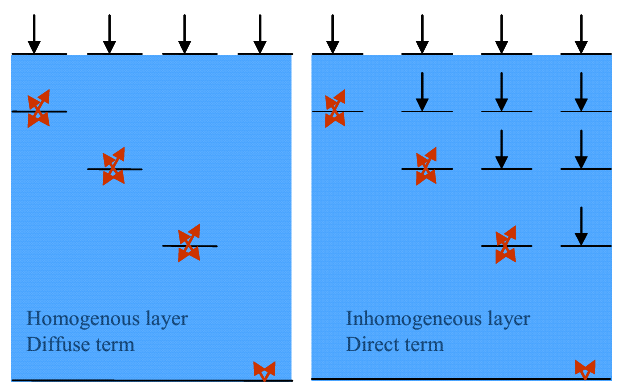
Figure 2. Schematic diagram showing the homogenous (left) and inhomogeneous radiative transfer concepts (right) with the diffuse and direct terms for the layers in the water column from the sea surface to sea